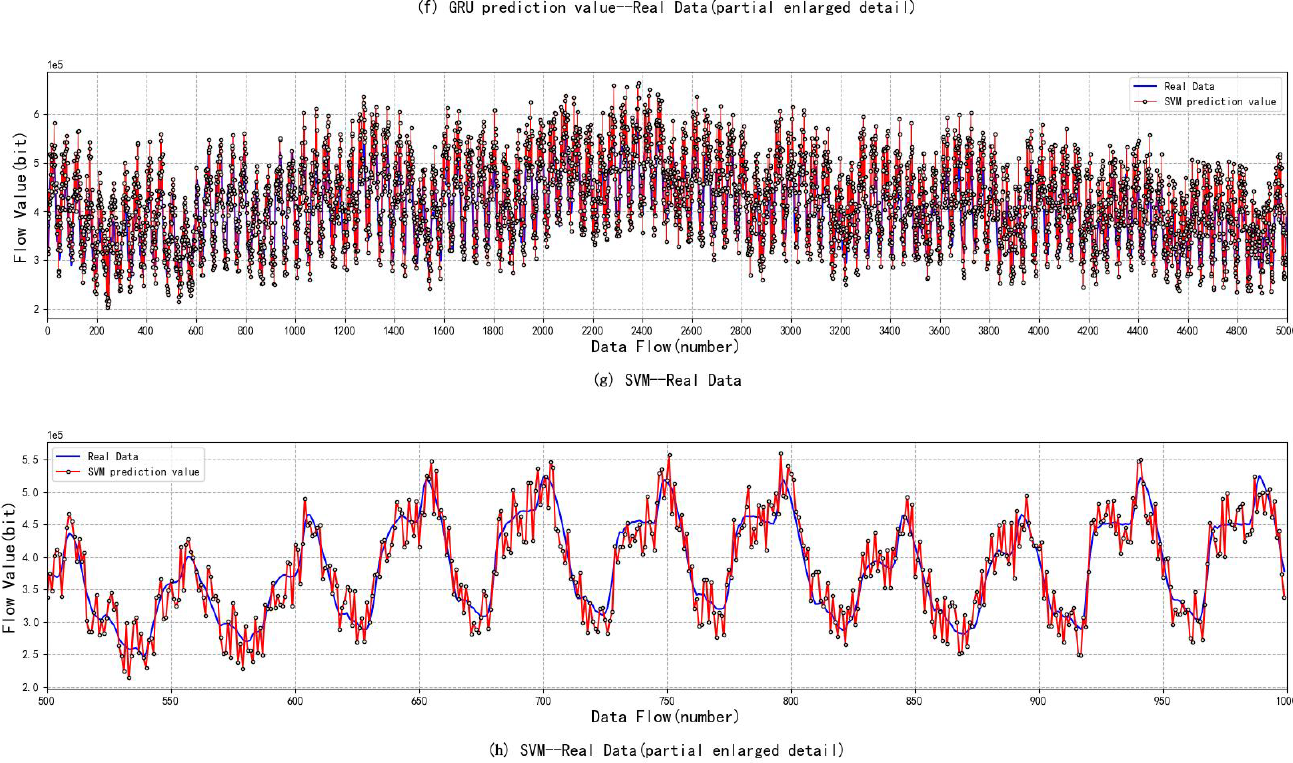
Figure 10. Comparison of prediction effects of different prediction models.